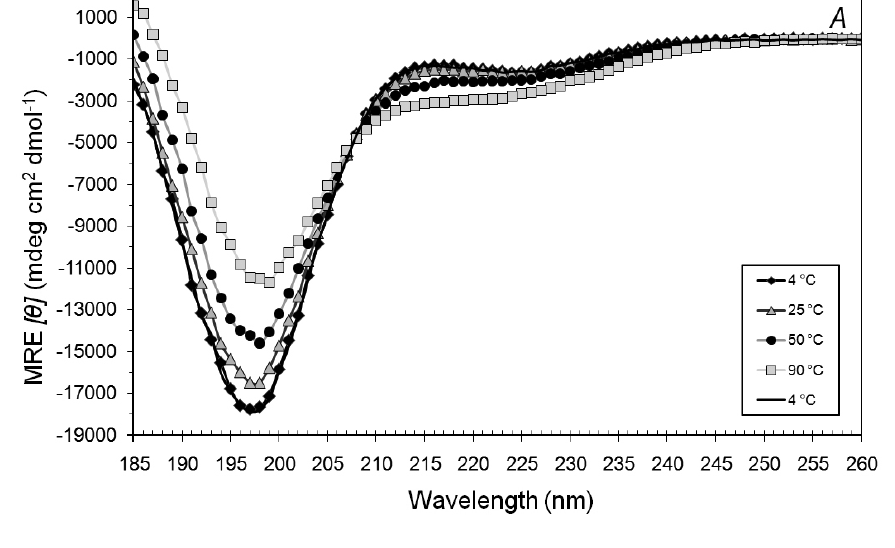
K, ( B ) 0.4 mM A D and 6 6